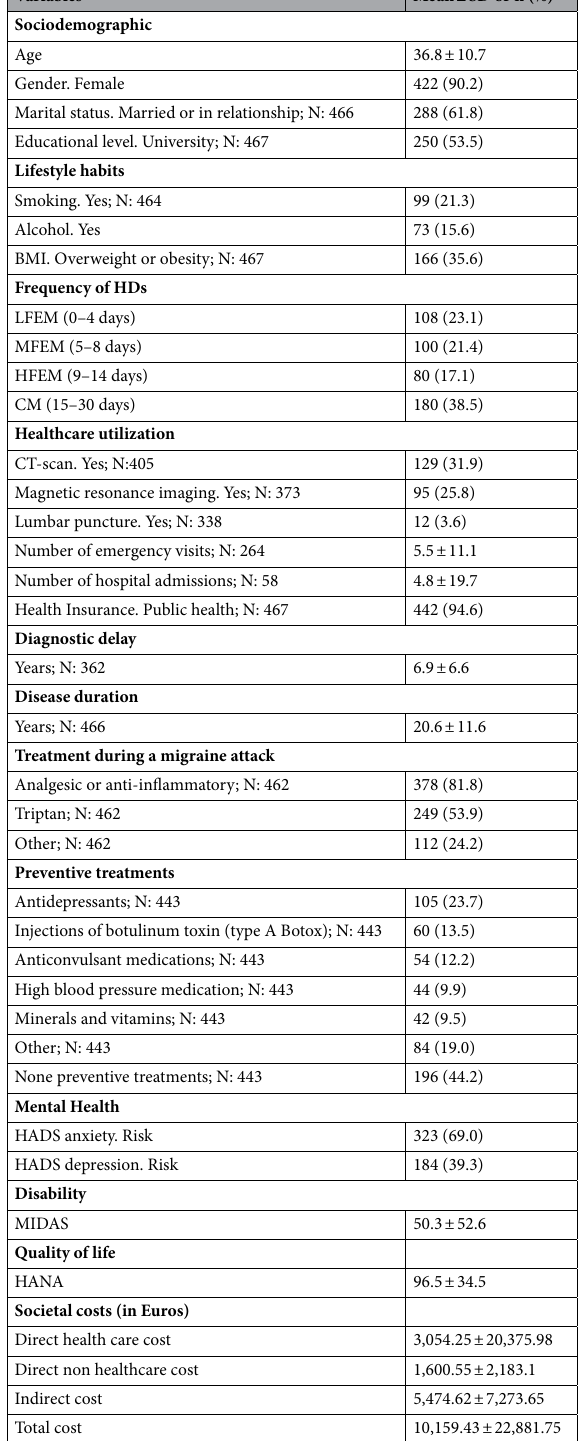
Table 1. Sociodemographic characteristics, Patient-reported Outcomes (HADS, HANA and MIDAS) & Healthcare Resource Utilization (N = 468, unless otherwise specified). PRO patient-reported outcome; HADS hospital anxiety and depression scale; HANA headache needs assessment; MIDAS migraine disability assessment scale; LFEM (Low-frequency episodic migraine); MFEM (Medium-frequency episodic migraine); HFEM (High-frequency episodic migraine); CM (Chronic